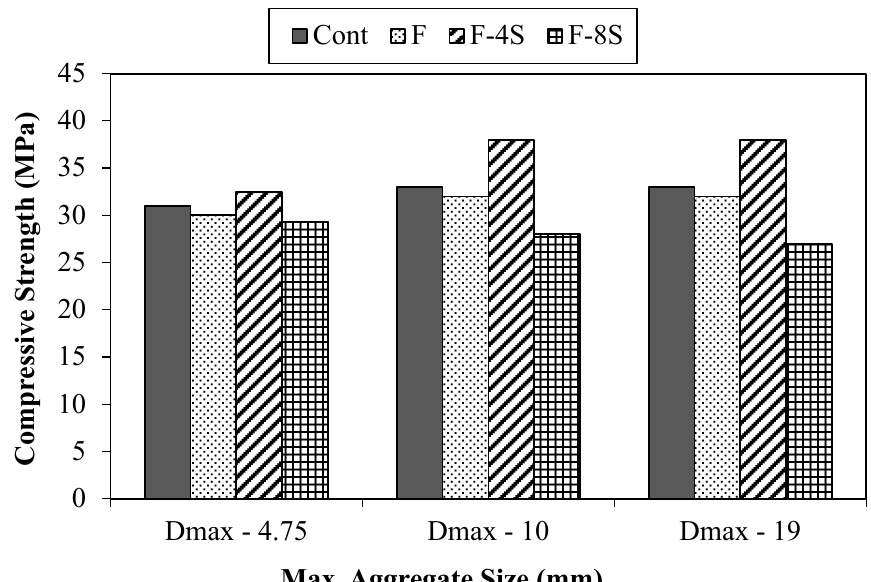
Figure 8. Compressive strength results.